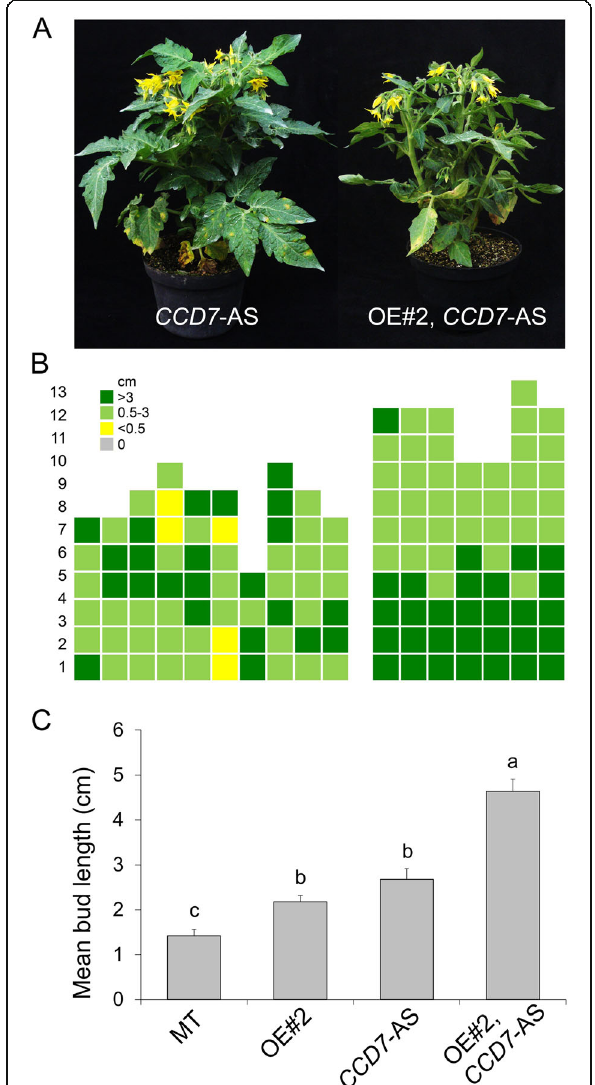
Fig. 4 Strigolactone depletion increases shoot branching in tomato plants overexpressing CKX2. A . Representative phenotype of antisense for CCD7 gene (CCD7-AS) and the double transgenic OE#2, CCD7-AS (OE#2 was used here as an abbreviation of CKX2-OE#2). B. Schematic representation of axillary bud formation in leaf axils in the sympodial axis of CCD7-AS and CKX2-OE#2, CCD7-AS plants at anthesis. C . Mean bud length of MT, CKX2-OE#2, CCD7-AS and CKX2-OE#2, CCD7-AS plants. Data are means ± SE . Letters indicate significant differences between genotypes (Tukey test; P <